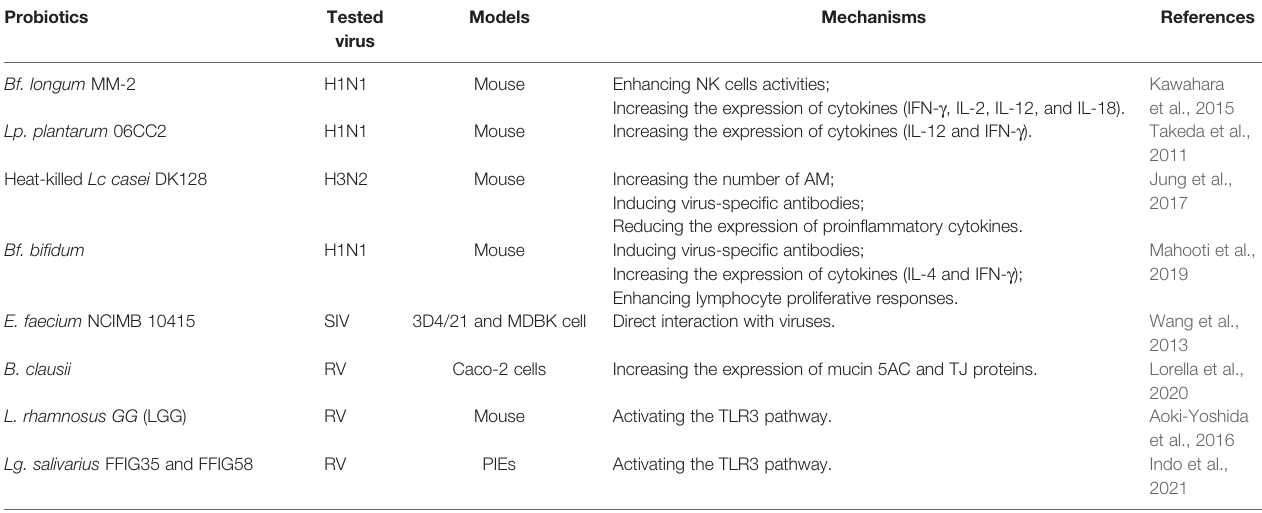
TABLE 1 | Antiviral effects and underlying mechanisms of various probiotics.